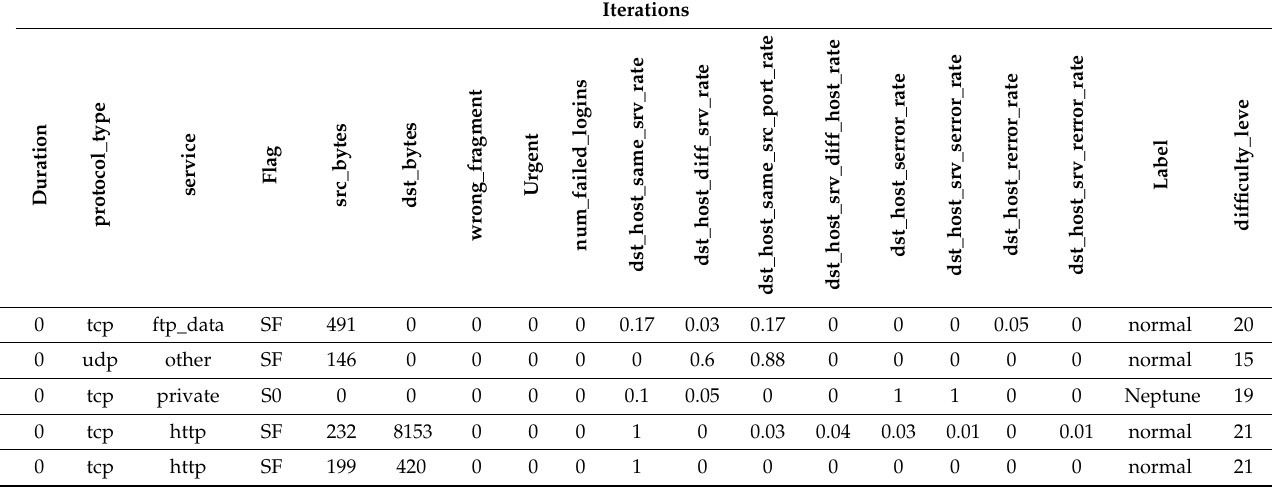
Table 5. Data frames